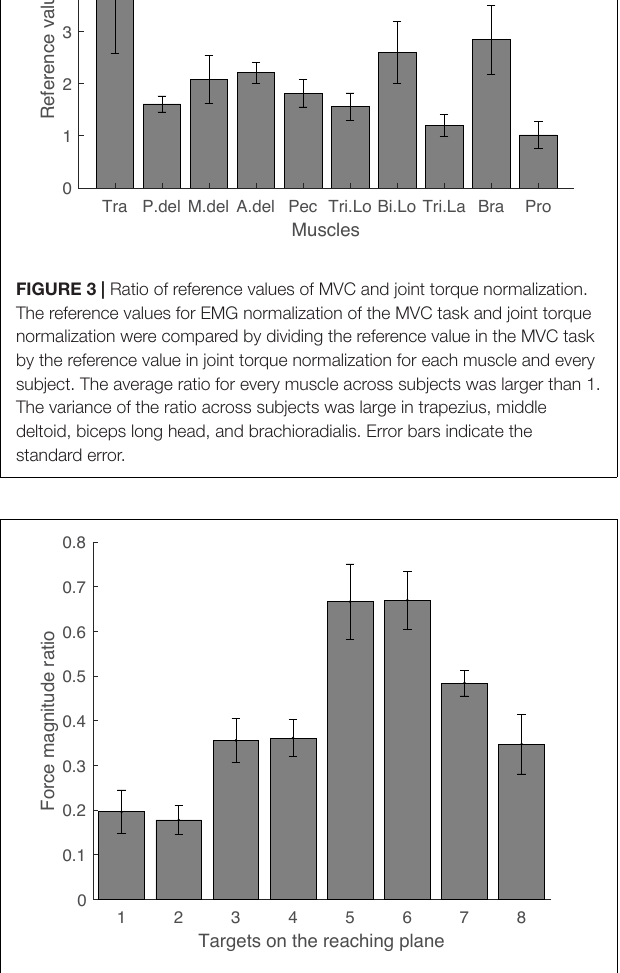
FIGURE 4 | Ratio of magnitudes of perpendicular and in-plane forces for each target during MVC task. Error bars indicate the standard error across